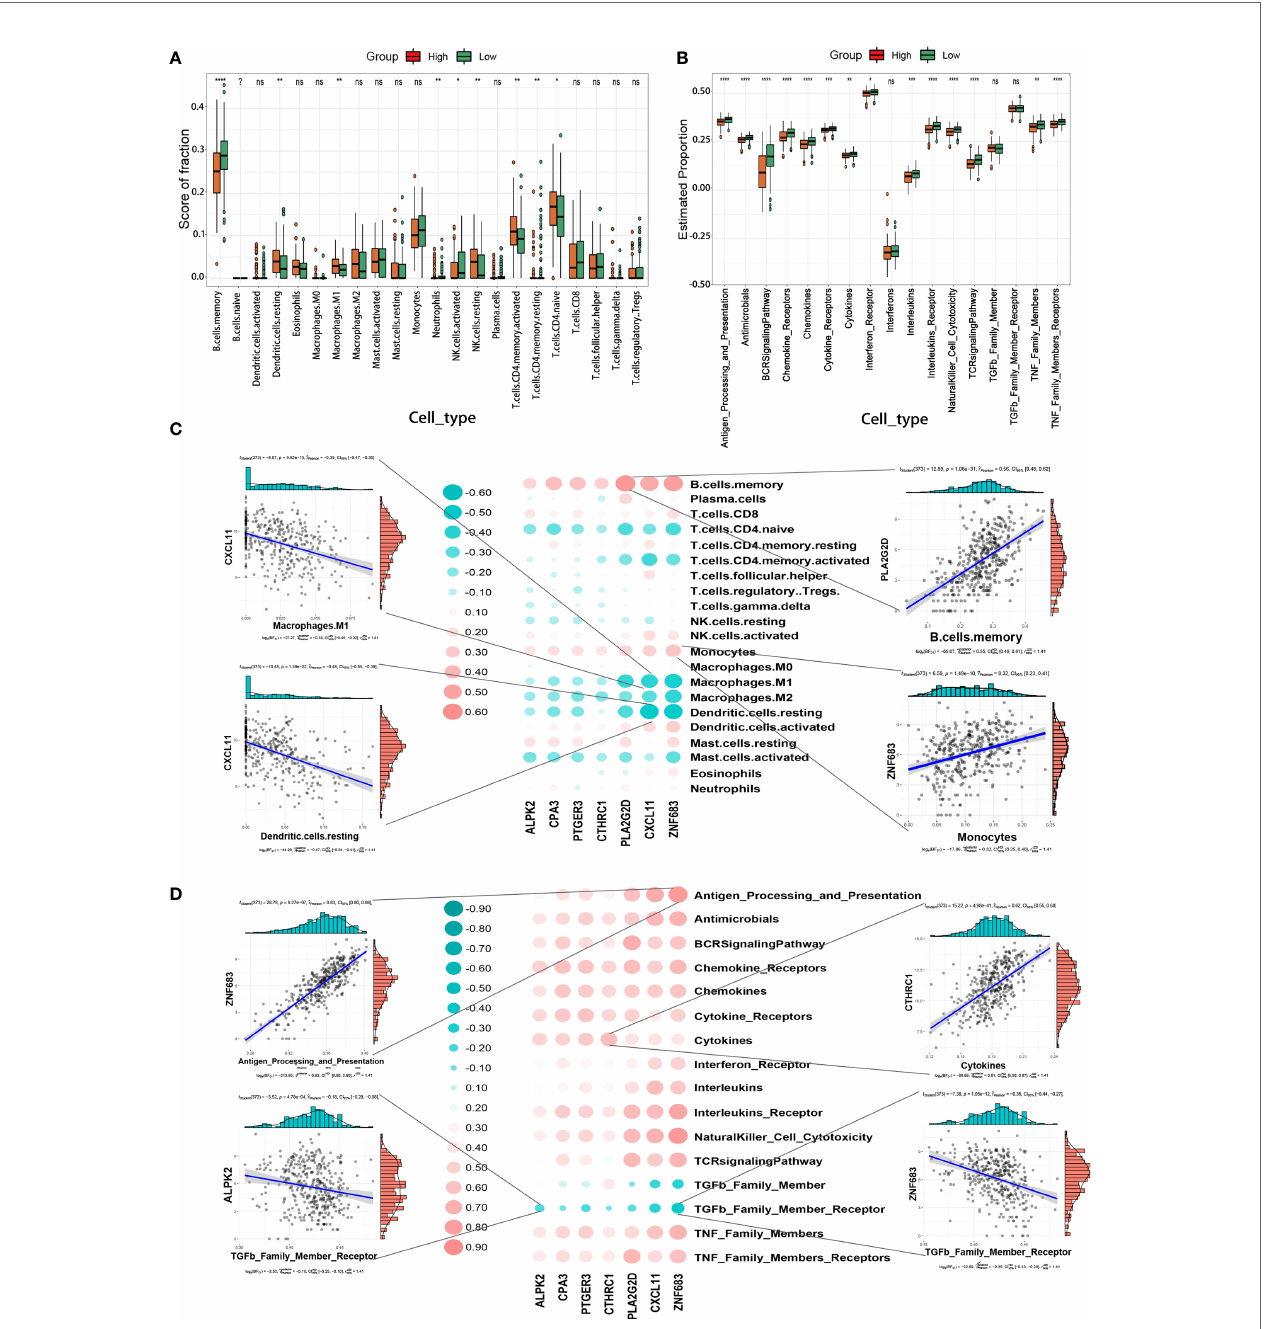
FIGURE 6 | TIMErisk is associated with EOC immune signature. (A) The differences in abundances of each immune microenvironment in fi ltrating immunocyte for TIMErisk subgroup in TCGA training cohort. (B) The activity differences for each immune reaction gene-set of TIMErisk subgroup in TCGA training cohort. (C) Dot-plot demonstrates the correlation between each dysregulated immune microenvironment in fi ltration cell type and TIME regulators in the TCGA training cohort. (D) Dot-plot demonstrates the correlation between dysregulated immune reaction gene-set and the TIME regulators in TCGA training cohort. Data are presented as mean±SD, ns p> 0.5. *p < 0.5; **p<0.01; ***p<0.001; ****p<